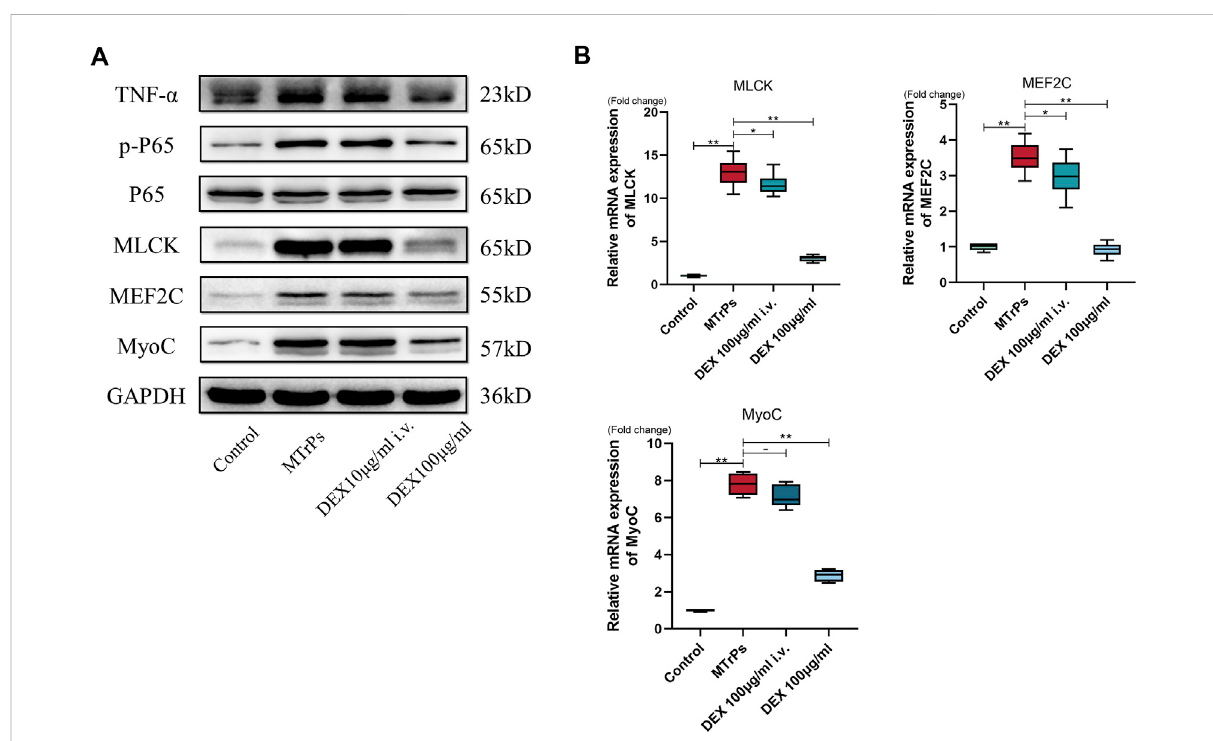
FIGURE 8 The proposed role of MEF2C in the in fl ammatory pathogenesis of MTrPs.